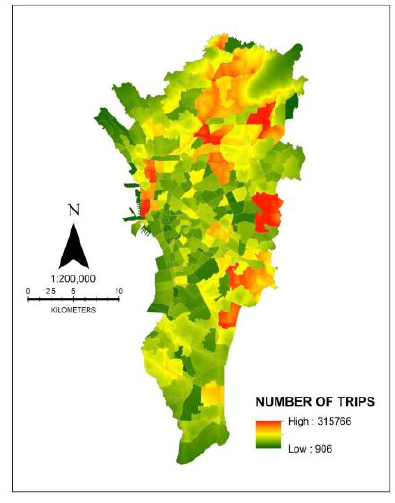
Figure 11. Suitable OD Malls